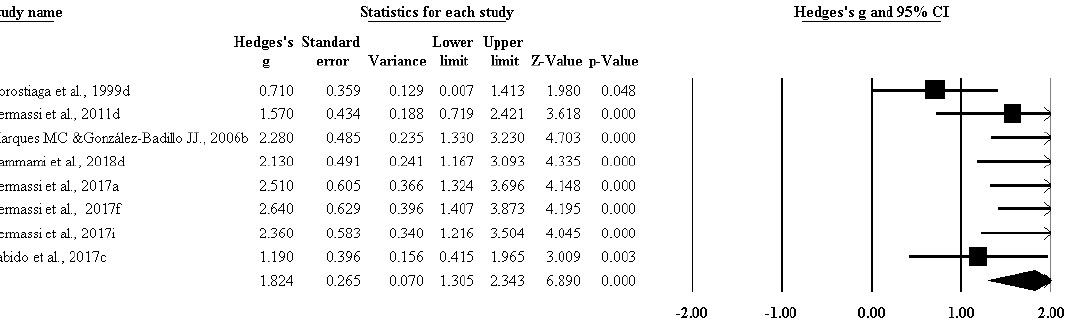
Figure 5. The impact of resistance training on maximal strength among handball players.